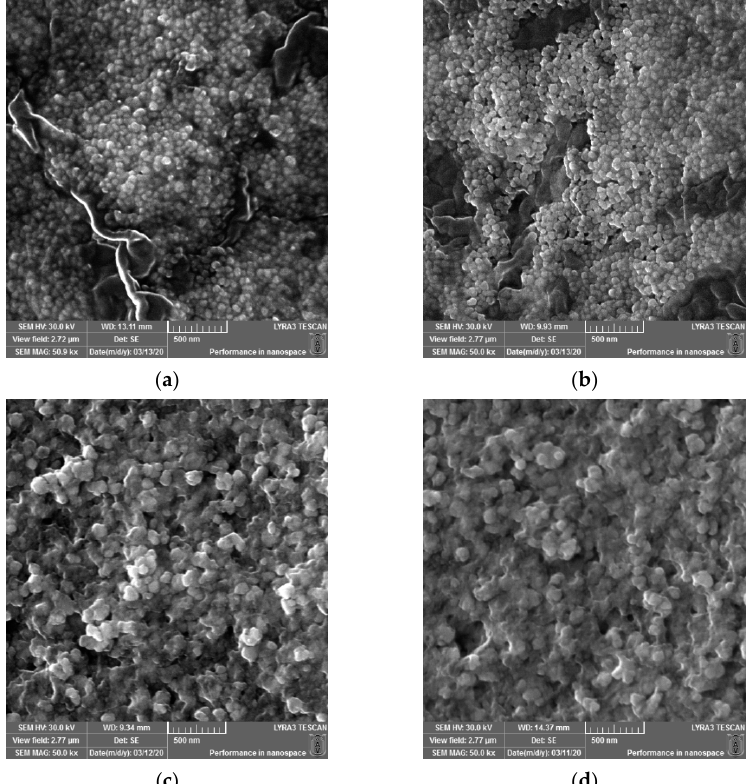
Figure 2. SEM micrographs recorded for the biosynthesized silver nanoparticles (AgNPs) obtained using Cannabis sativa leaves extracts: PDi ( a ), PDe ( b ), PSm ( c ), and PSf ( d ).